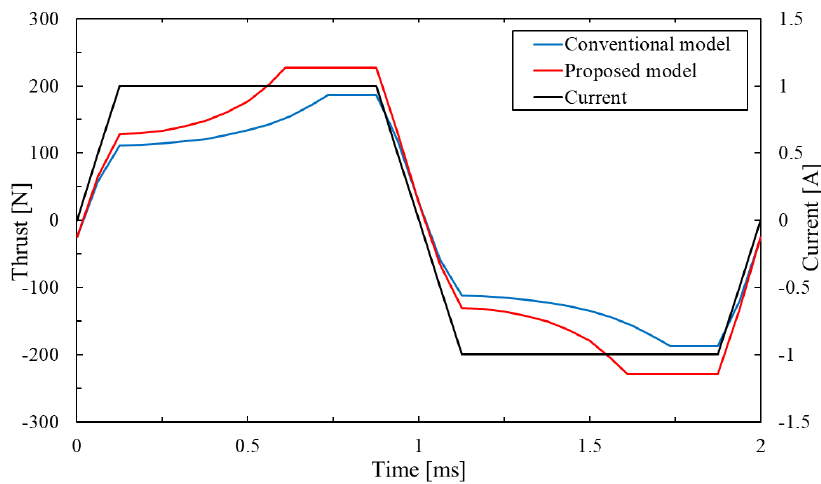
Figure 8. Thrust waveforms of the conventional model and proposed model.